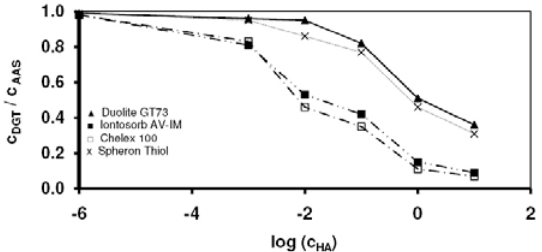
Figure 4. Influence of humic substance concentration to measurement of mercury by DGT technique with various sorption